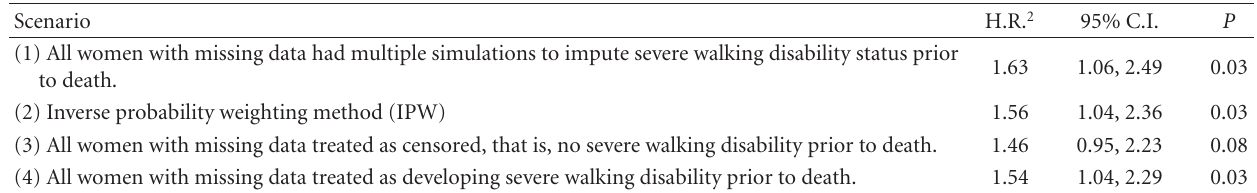
Table 3: Multivariate cox proportional hazard models for serum CML and development of severe walking disability, ( N = 394) 1 .